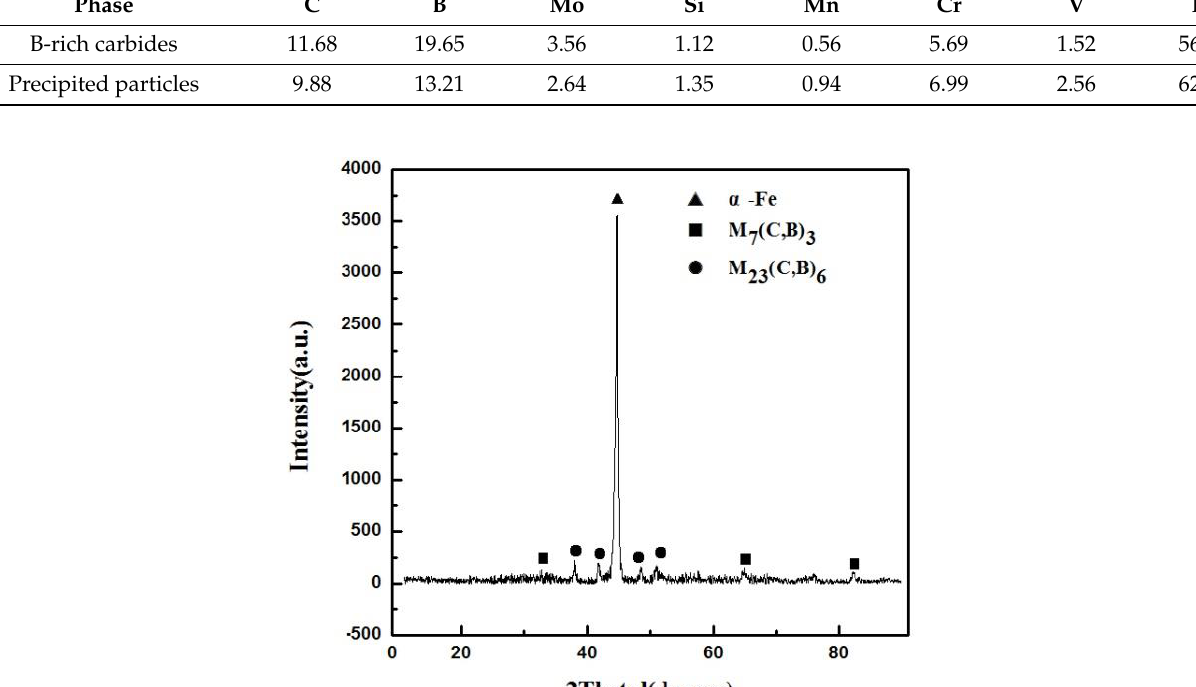
Figure 11. XRD result of B-bearing high-speed alloy steel after tempering.